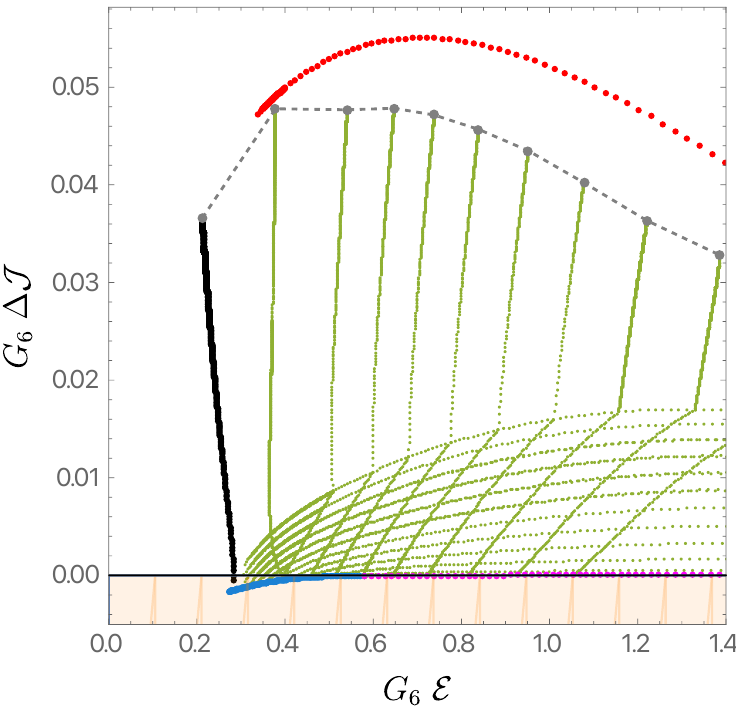
Figure 6 . Phase space of black resonator string solutions and Kaluza-Klein geons. The green points are black resonator strings and the red points are Kaluza-Klein geons. As far as we can tell, black resonator strings and Kaluz-Klein geons do not overlap. Black resonator strings merge with Myers-Perry black strings at the onset curve given by blue points. The magenta points are our best estimate of where black resonator string are extremal. The black points on the left are where black resonator strings cease being bound states. The gray points mark turning points where black resonator strings have maximum angular momenta. There is (at least) a second set of black resonator strings that exist just below this gray curve, ending in a curvature singularity (which also lies somewhere just below this gray